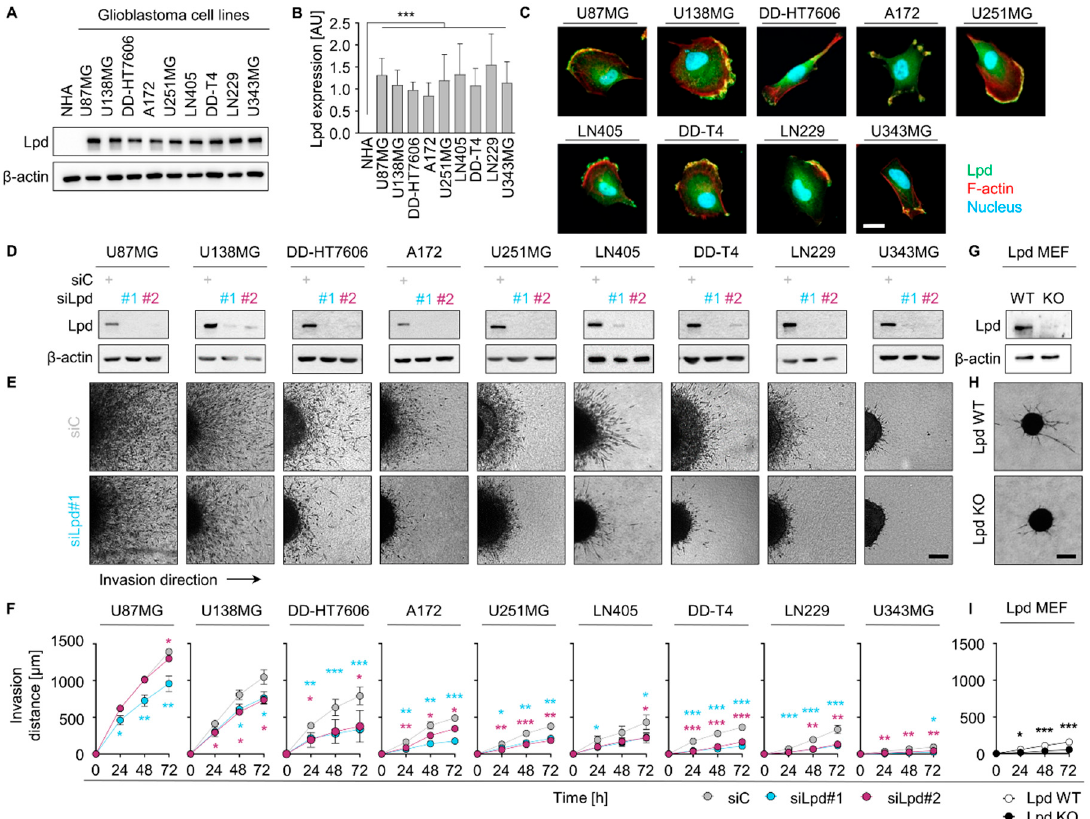
Figure 1. Lamellipodin promotes glioblastoma cell invasion. ( A ) Western blot analysis of Lpd expression in whole-cell lysates of normal human astrocytes (NHA) and indicated human glioblastoma cell cultures. β -actin served as loading control. ( B ) Densitometry analysis of Lpd expression from Western blots in ( A ). Lpd intensity was measured using ImageJ and normalized to β -actin intensity. Results are represented as mean ± SD ( n = 3, two-sided Student’s t -test, *** p < 0.001). ( C ) Representative confocal microscopy images of Lpd (green), F-actin (red) and nucleus (blue) in indicated 2D glioblastoma cells cultures plated on type I collagen. Scale bar, 20 µ m. ( D ) Western Blot analysis of knockdown efficiency 72 h after transfection of Lpd-specific and control siRNA in indicated glioblastoma cell cultures. β -actin served as loading control. ( E ) Representative phase-contrast images ( t = 72 h) and ( F ) invasion capacity of control and Lpd-depleted glioblastoma spheroids recorded 24 h, 48 h and 72 h after embedment in 3D type I collagen. Scale bar, 200 µ m. Cell lines are ordered by decreasing basal invasive capacity. Results are mean ± SD ( n = 3, two-sided Student’s t -test, * p < 0.05, ** p < 0.01, *** p < 0.001). ( G ) Western blot analysis of Lpd expression in whole-cell lysates from Lpd WT MEF and Lpd KO MEF. β -actin served as loading control. ( H ) Representative phase-contrast images ( t = 72 h) and ( I ) invasion distance of Lpd WT MEF and Lpd KO MEF spheroids measured 24 h, 48 h and 72 h after embedment in 3D type I collagen. Scale bar: 200 µ m. Results are presented as mean ± SD ( n = 3, two-sided Student’s t -test, * p < 0.05, ** p < 0.01, *** p < 0.001). Lpd, Lamellipodin; AU, arbitrary units; si, small interfering RNA; C, control; WT, wild type; KO, knockout; MEF, mouse embryonic